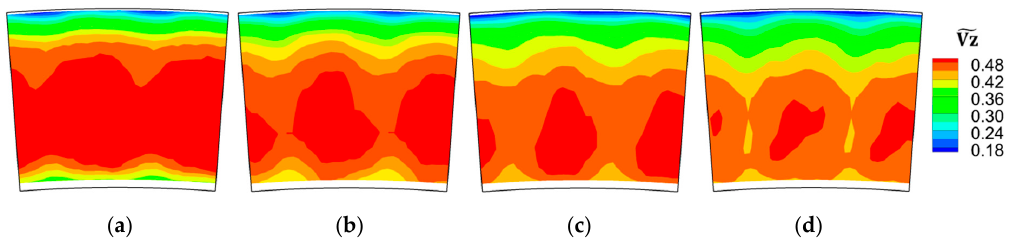
Figure 6. Normalized axial velocity contours of each rotor outlet. ( a ) R1 Outlet; ( b ) R2 Outlet; ( c ) R3 Outlet; ( d ) R4 Outlet.